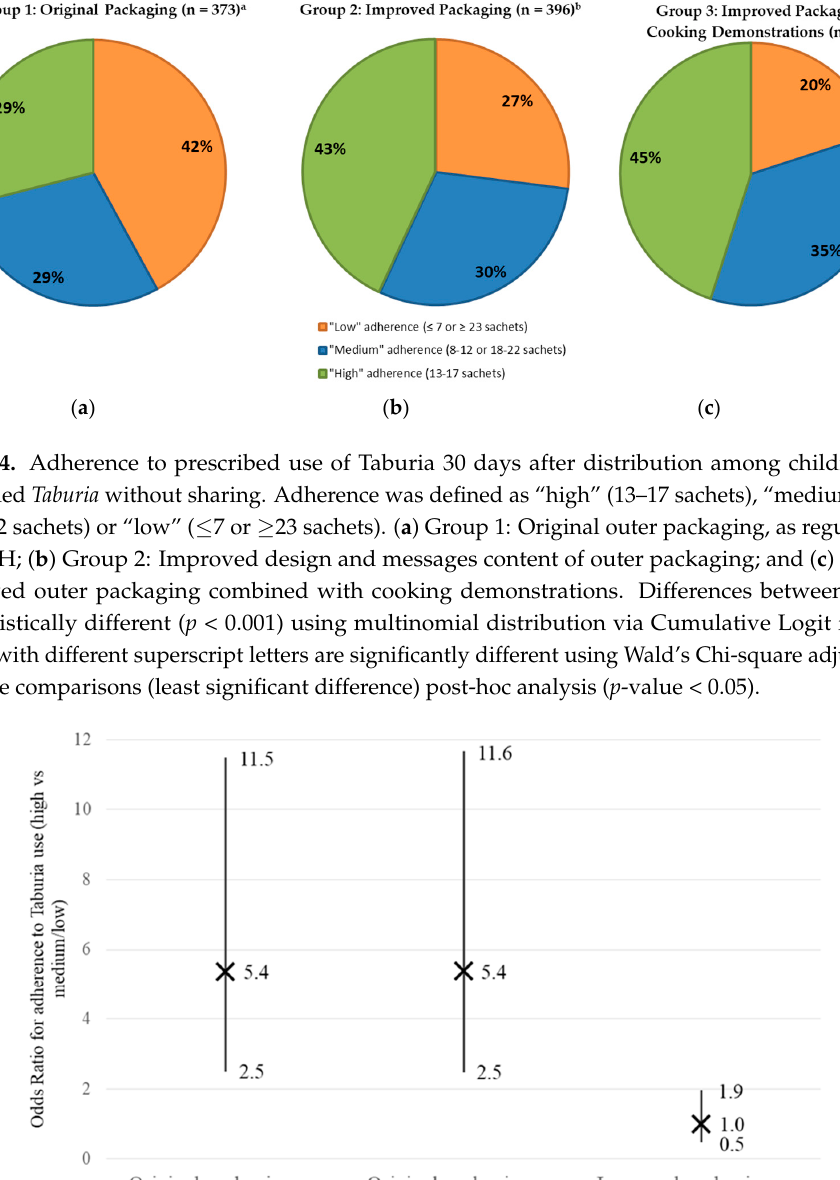
Figure 5. Odds ratios comparing “high” (13–17 sachets) versus “medium/low” ( ≤ 12 or ≥ 18 sachets) adherence with prescribed use of Taburia 30 days after distribution among the three study groups. Group 1: Original outer packaging, as regulated by the MoH; Group 2: Improved design and messages content of outer packaging; and Group 3: Improved outer packaging combined with cooking demonstrations. Odds ratio pairwise comparisons were performed using a nested design in a Logistic Regression Model. The X represents the odds ratio and the error bars represent 95% confidence intervals.